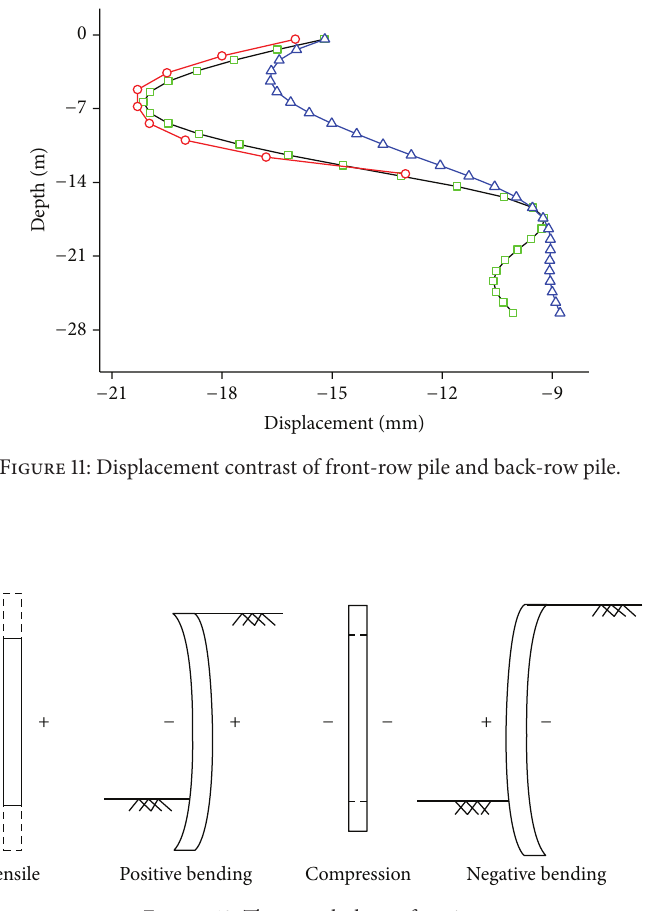
Figure 12: The morphology of